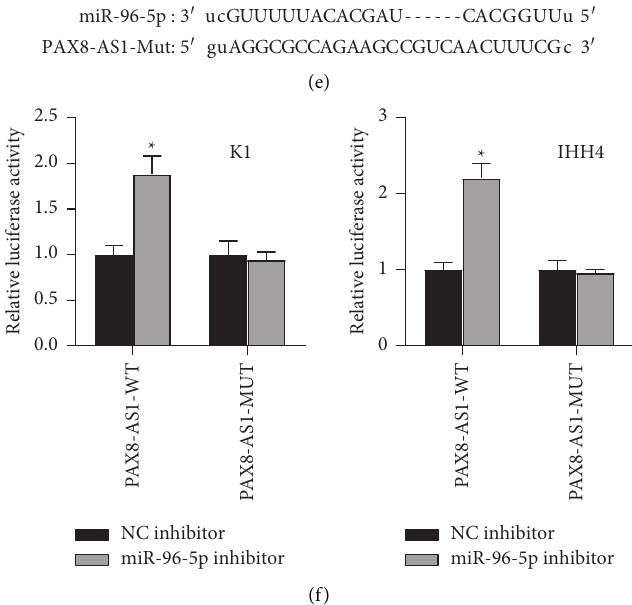
Figure 3: PAX8-AS1 binds with miR-96-5p. Note. (a) ENCORI website showed two candidate miRNAs (miR-107 and miR-96-5p) holding binding sites with PAX8-AS1; (b) ENCORI website showed the expression of miR-96-5p and miR-107 in THCA tissues compared to normal tissues; (c) the expression of miR-96-5p in PTC cells compared to normal cells by qRT-PCR; (d) the transfection efficiency of miR-96-5p inhibitor in PTC cells was examined by qRT-PCR; (e) ENCORI website showed a binding region of miR-96-5p on PAX8-AS1; (f) the binding relationship of PAX8-AS1 and miR-96-5p was validated by luciferase reporter assay; ∗ P < 0 . 05 , ∗∗ P < 0 . 01 , and ∗∗∗ P < 0 . 001.